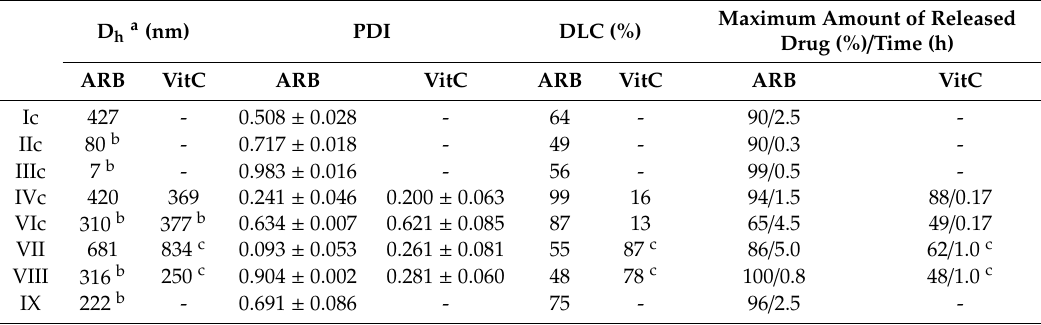
Table 3. Characteristics of encapsulated particles and release of active